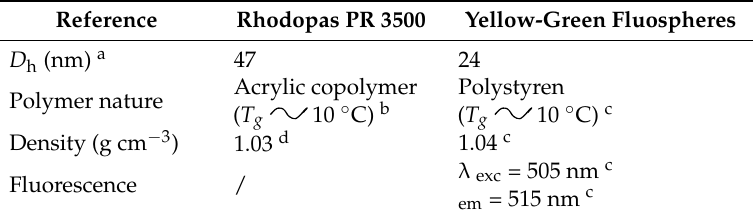
Table 2. Features of film-forming and fluorescent nanoparticles